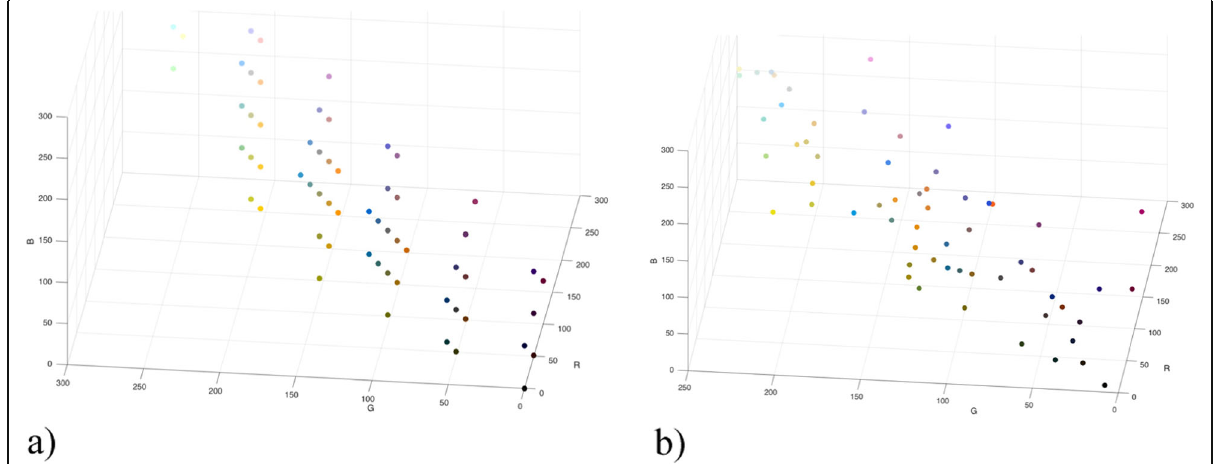
Fig. 7 Color space distribution for an image of the standard palette ( a ) and how the palette looks after stegomessage embedding ( b